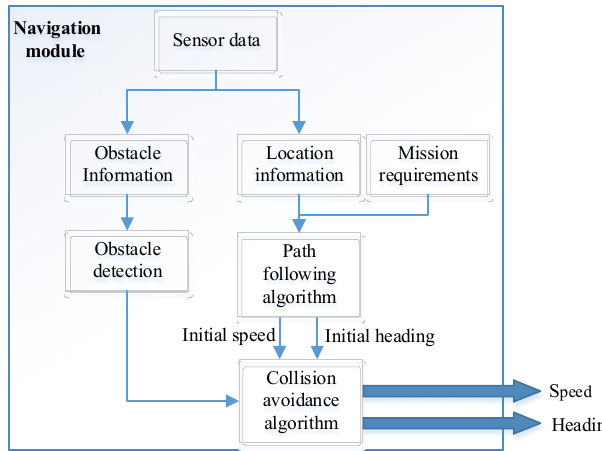
Figure 4. Navigation module.